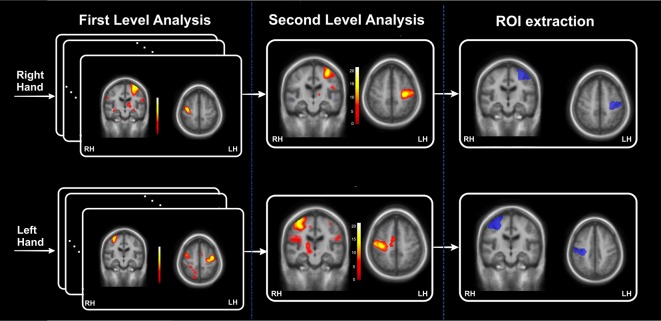
The block diagram relative to the definition of activation regions of interest (ROIs) extracted from the control’ statistical maps. This block diagram is divided into three parts: a first-level statistical analysis applied for each of the individual functional magnetic resonance imaging (fMRIs) of the 30 controls, second-level analysis to obtain the activation statistical maps and finally extraction of the activation ROIs as the cluster with the maximum t-values.